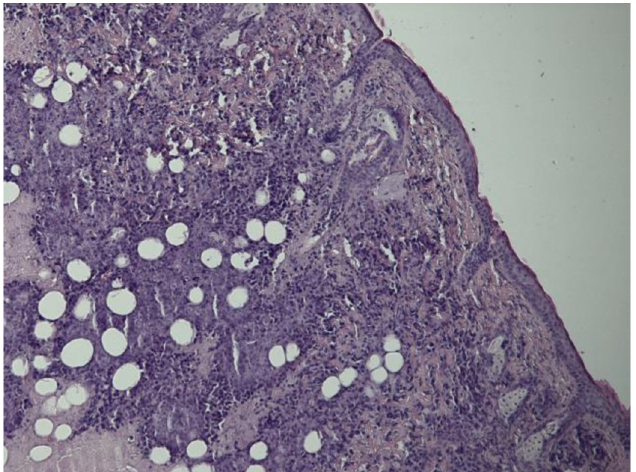
Figure 3. This photomicrograph (H&E stain, 100 × ) shows the carcinoma tumor infiltrating the skin. There is significant inflammation, necrosis and desmoplasia.